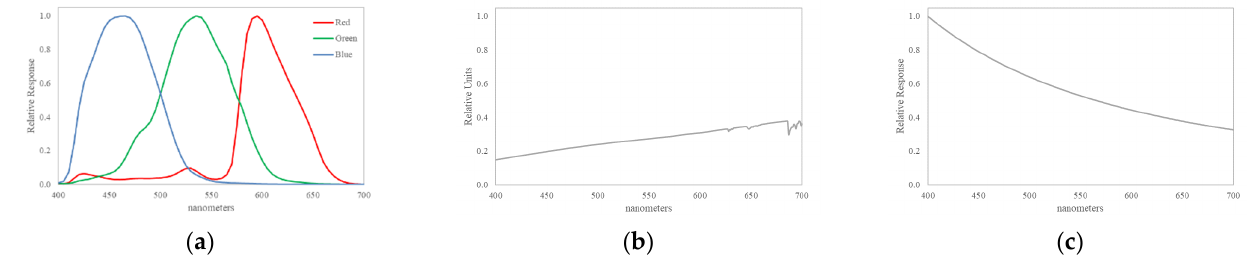
Figure 3. Graphical illustration of the constituents for synthetic bands’ radiance computation: spectral sensitivity of RGB bands of Nikon D4 DSLR camera ( a ), atmospheric transmittance ( b ), and reference spectrum of AB magnitude system ( c ).